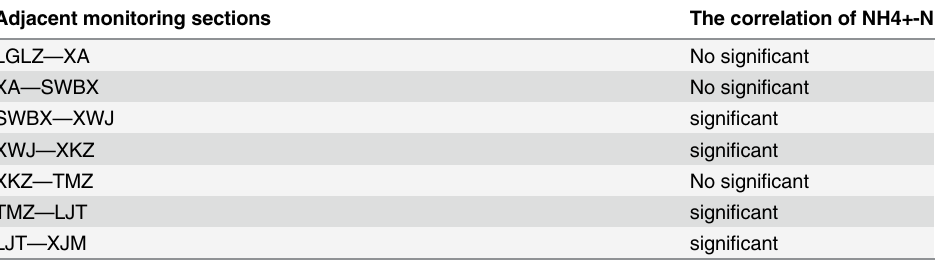
Table 3. The correlation of NH 4+ -N between neighboring monitoring sections in main stream of Tai- zihe River. Adjacent monitoring sections The correlation of NH4+-N